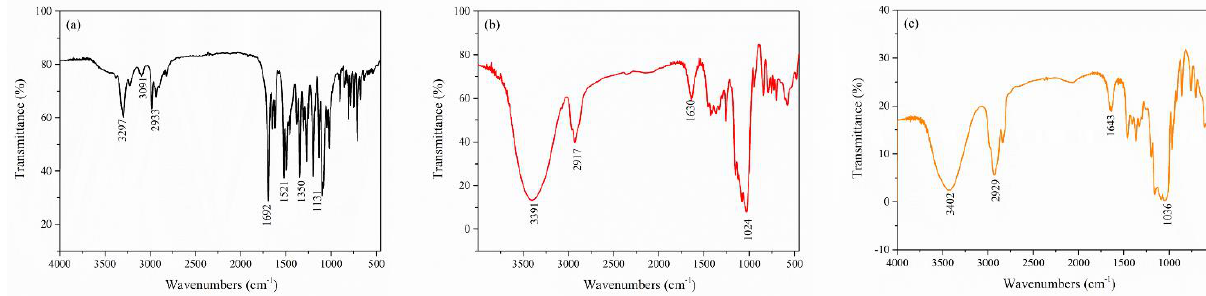
Figure 2. FTIR spectra of ( a ) Nim; ( b ) HP- β -CD; ( c ) Me- β -CD.